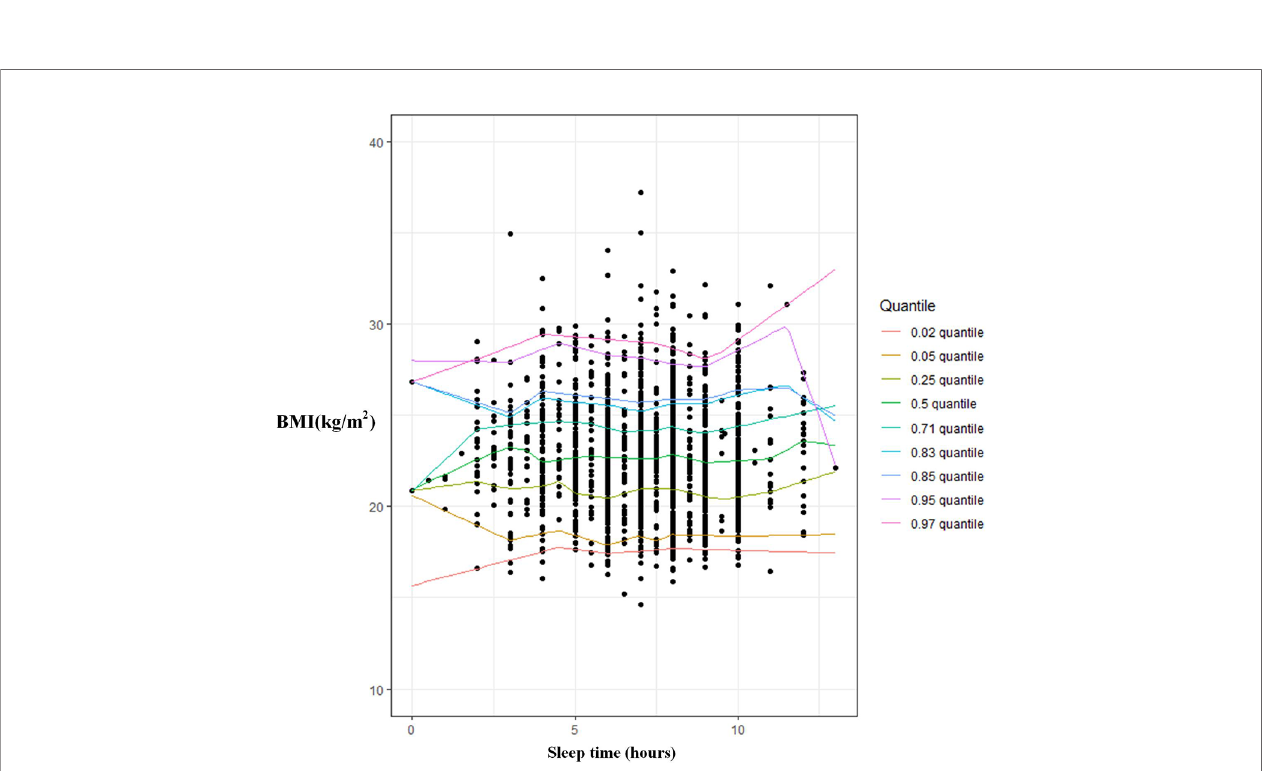
FIGURE 2 | The association between sleep duration and BMI among women using multivariate quantitle regression